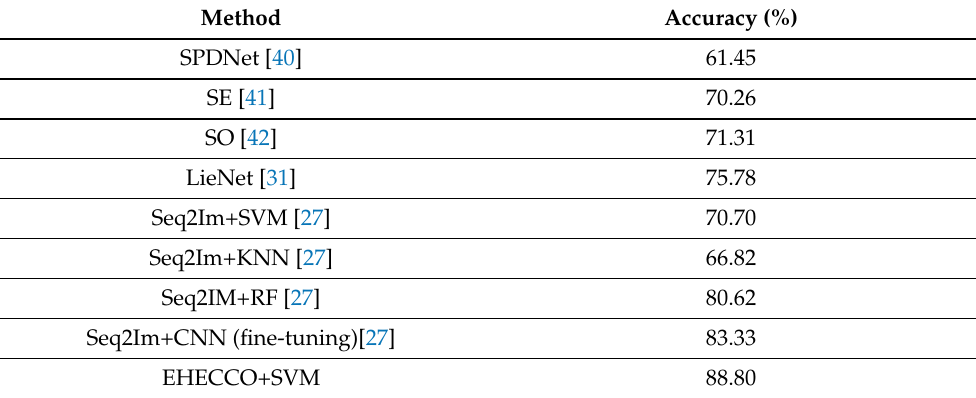
Table 2. Comparing results of Mocap-based style/subject recognition (HDM05 dataset). The average accuracy is reported concerning the cited works vs. our approach—EHECCO+SVM.